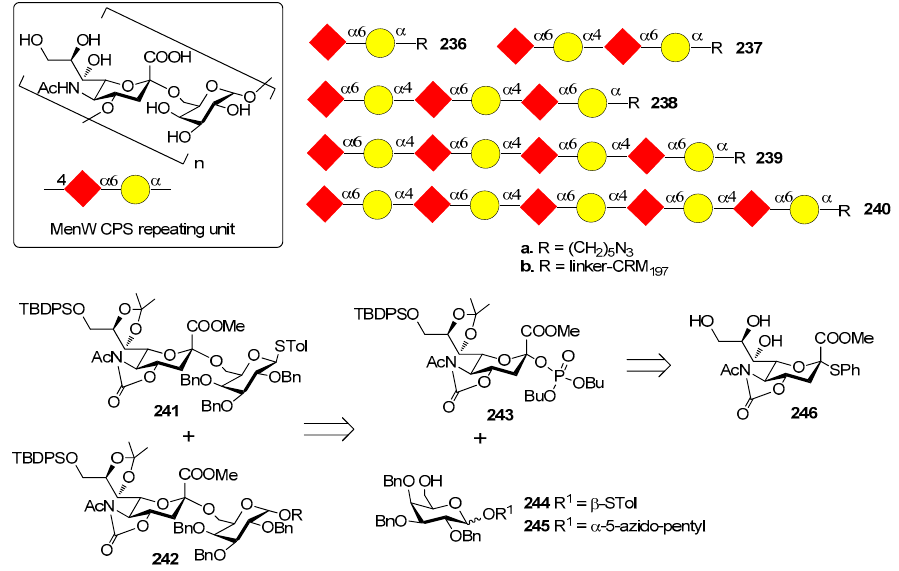
Figure 26. Repeating unit of MenW CPS and synthetic strategy used the construction of MenW CPS fragments [194].